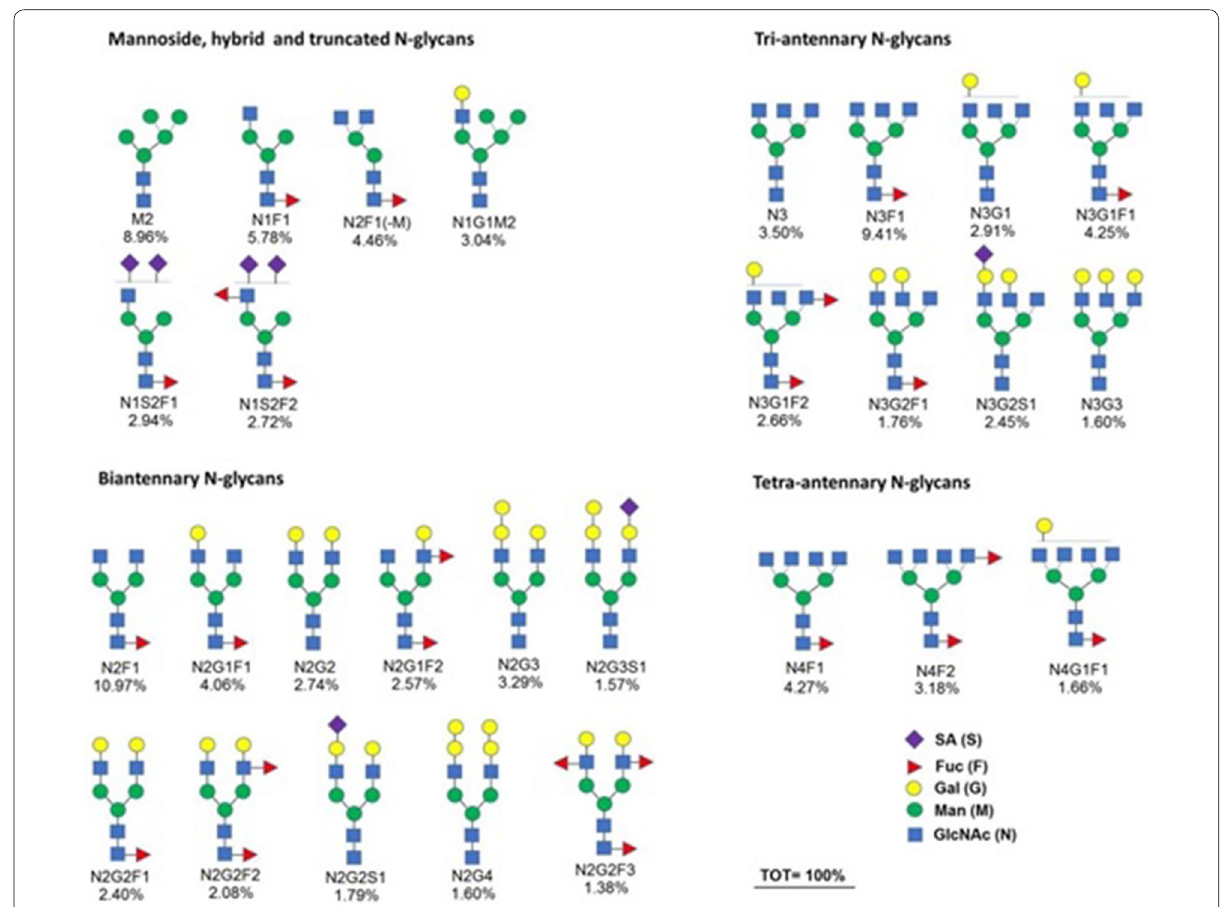
Fig. 6 N-glycan structures of HEK-G-hPRL: the relative percent intensity is indicated below each glycan